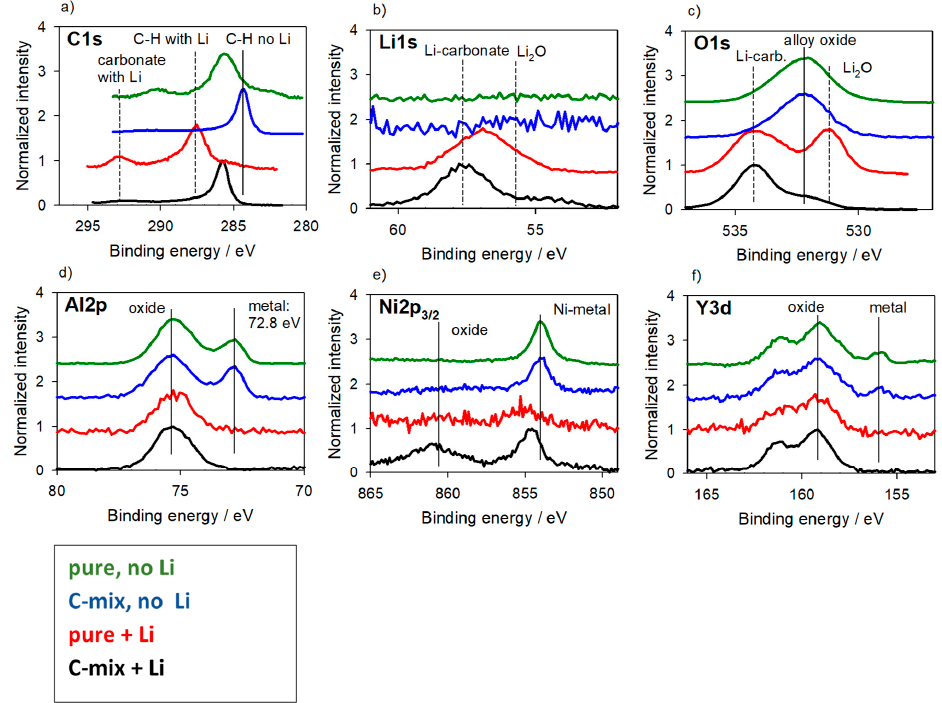
Figure 9. XP spectra normalized in intensity of AlYNi-based powder material: doped with Li and mixed with carbon black, only doped with with Li, undoped powder mixed with carbon black, undoped pure powder ( bottom to top ). BE calibration was done with Al2p (72.8 eV—metal, than 75.3 eV